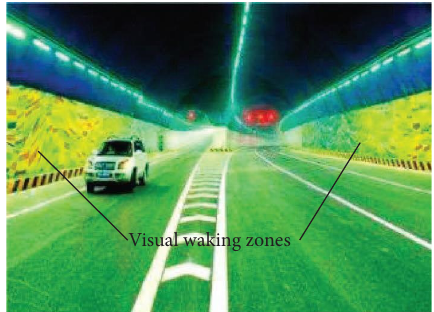
Figure 15: Visual waking zones on tunnel sidewalls [42].